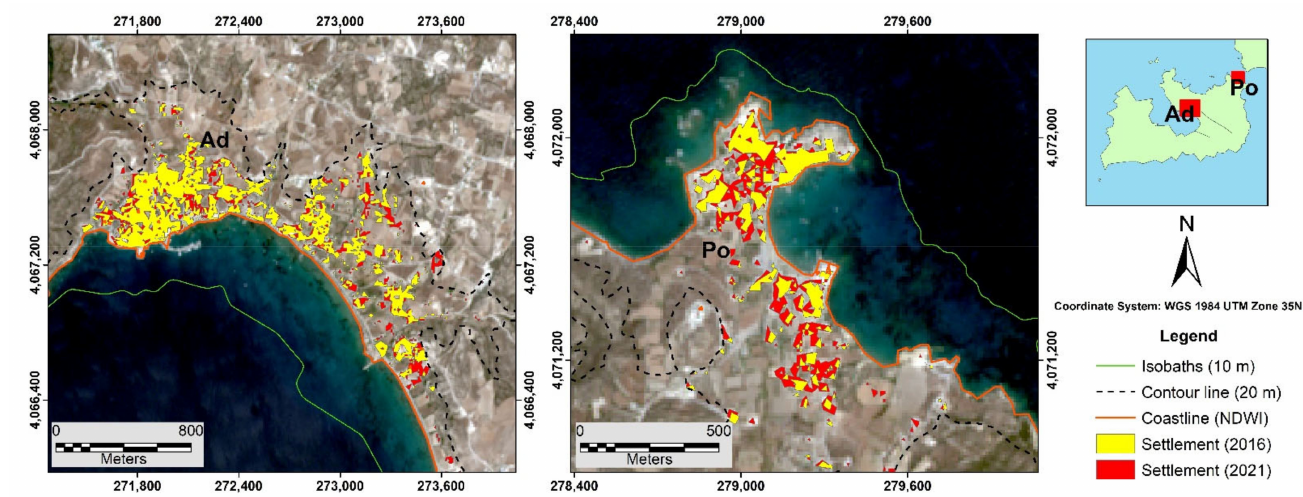
Figure 16. The map is illustrating the urban changes during the period 2016–2021 in Pollonia and Adamas settlements. The orange line is the coastline derived from NDWI, the green line is the isobath (10 m) extracted by the SDB, and the black dashed lines are the upper limit of the landward region regarding the elevation of 20